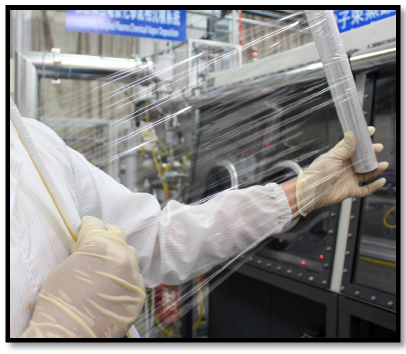
Figure 7. Photograph of stretched and rolled PMP with three-pair SiO x /SiC x H y stack.